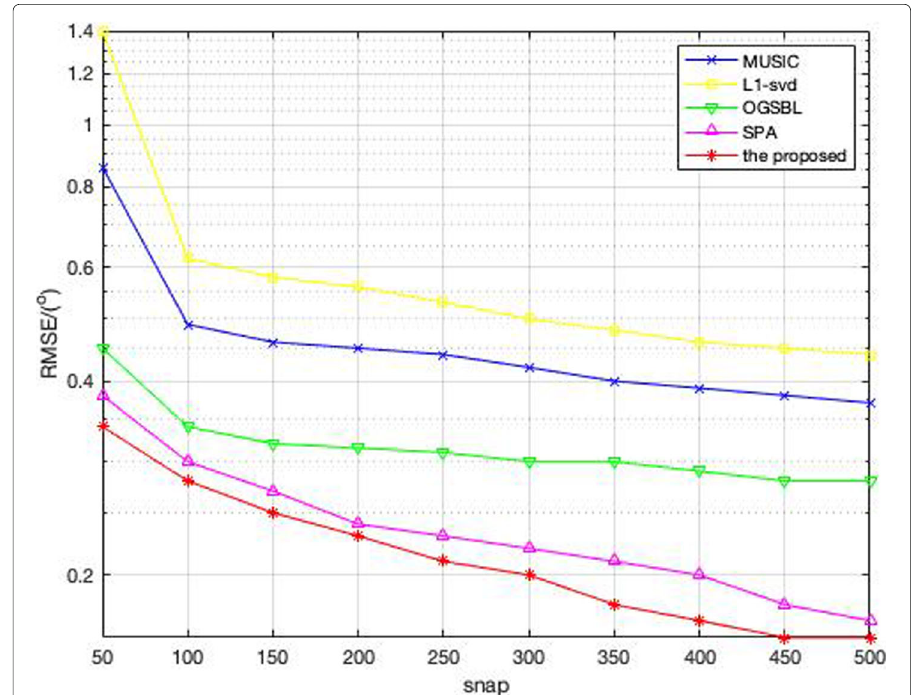
Fig. 4 RMSEs of five algorithms versus snapshots